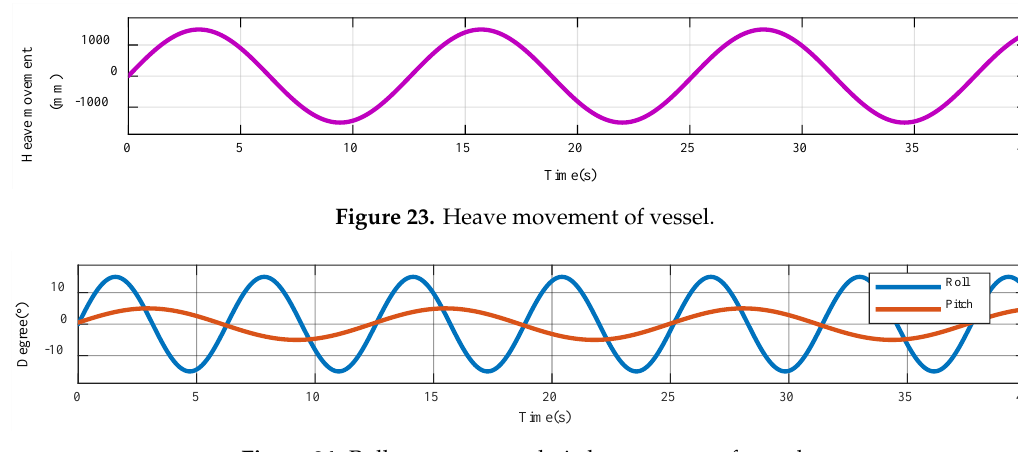
Figure 24. Roll movement and pitch movement of vessel.